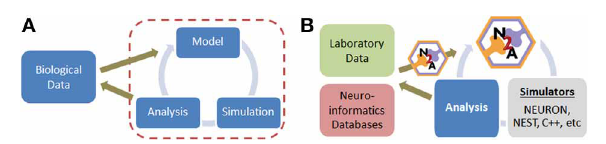
FIGURE 1 | (A) Simple overview of computational modeling process and relationship to neurobiological data. (B) Illustration of where N2A tool contributes to neural modeling studies; we envision that N2A will eventually be capable of mapping into a wide range of common neural simulation platforms.